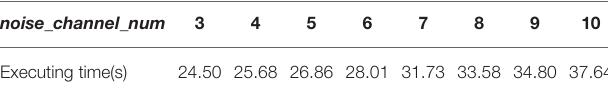
TABLE 5 | The relationship between en _ num and executing time.